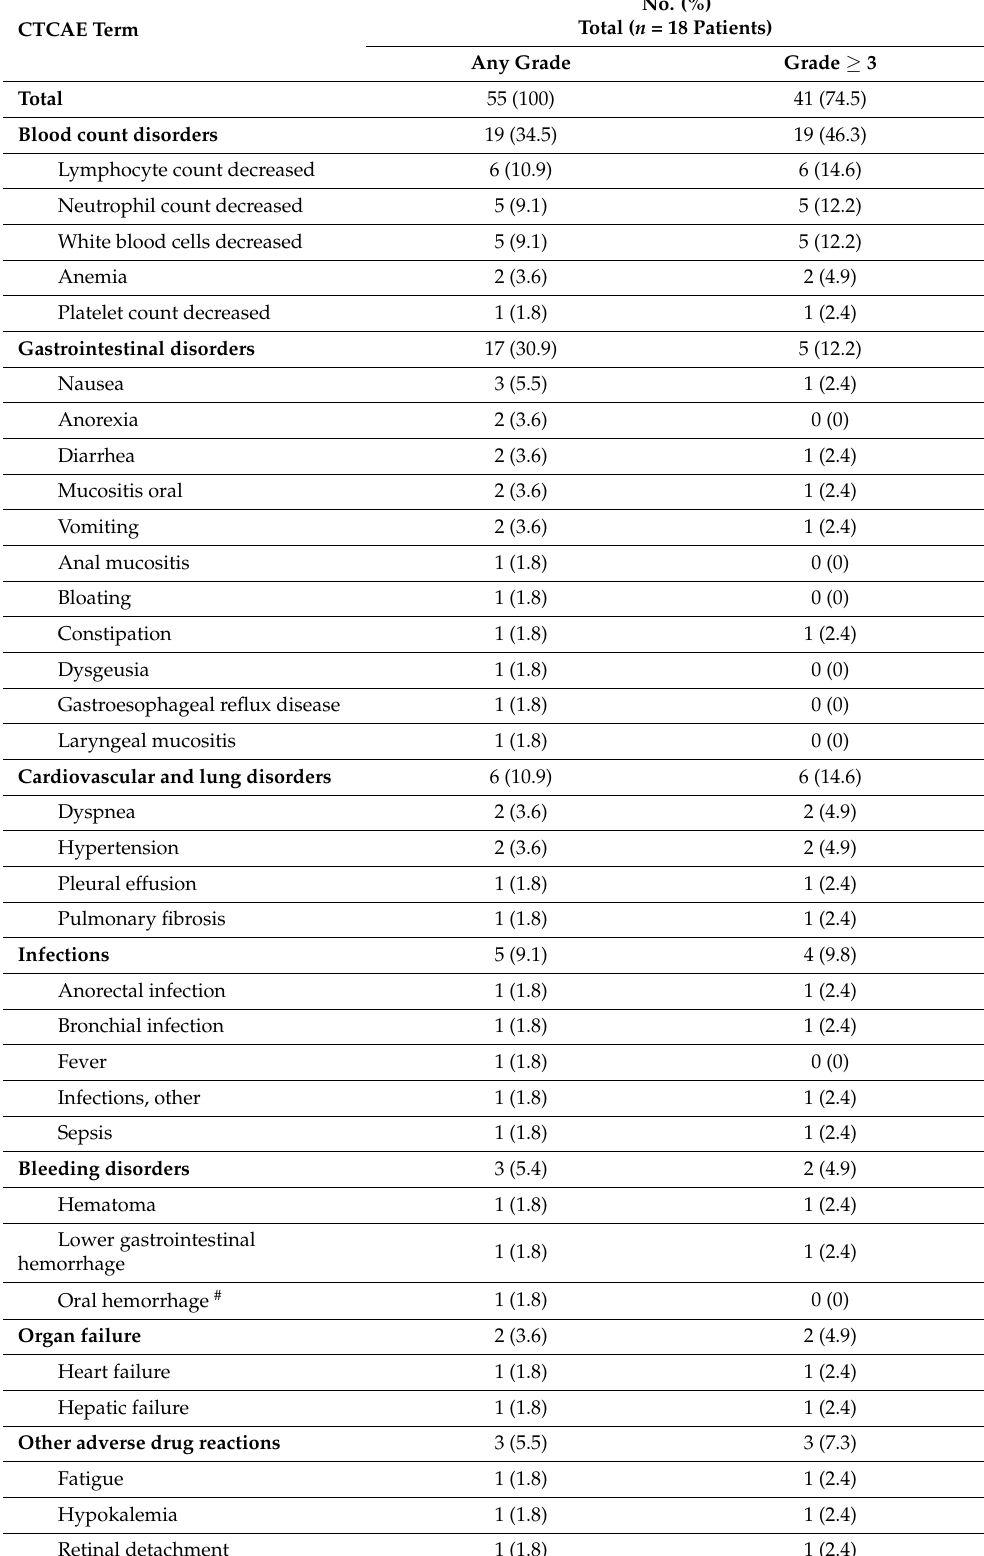
Table 2. Number of adverse drug reactions associated with OAT-related hospitalizations within